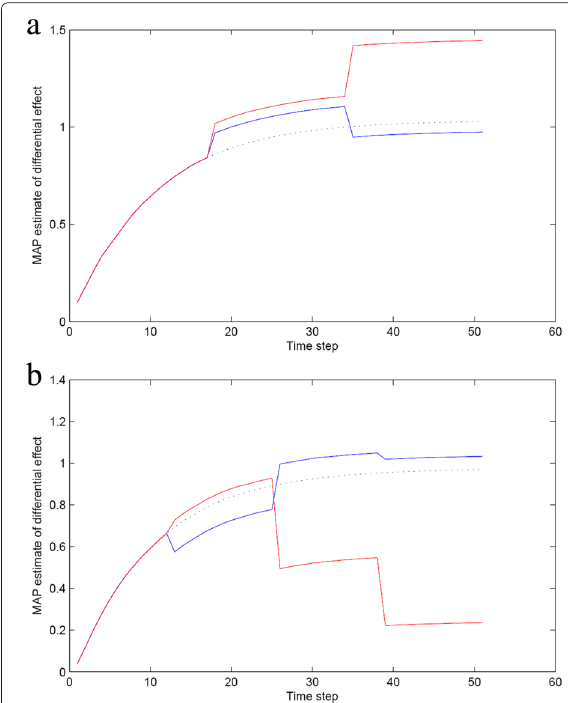
Fig. 4 Simulation examples. Shown are the running ground truth of the differential effect (black dotted line), the estimate when the designated number of samples is removed using the proposed pair-wise compatibility-based selection (blue line; see Section 2.2), and the estimate when the designated number of samples is removed using repeated random draws based sample selection (red line; see Section 2.4). The proposed method clearly outperforms the random draws based approach. a Two sample size reductions.